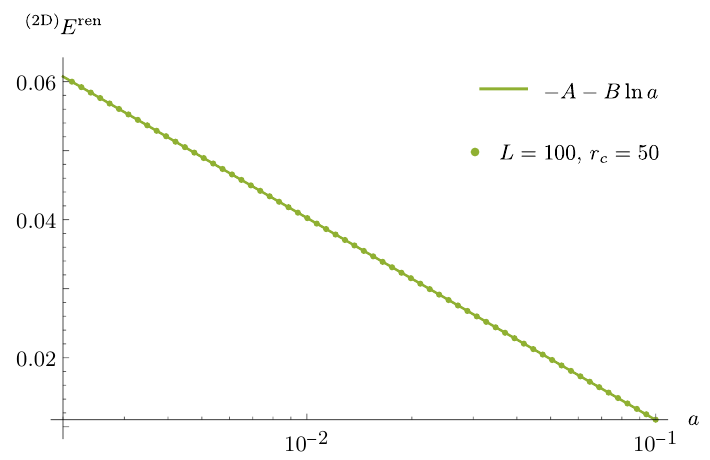
Figure 6 . Log-linear plot of the numerical Casimir energy (green data points) for R = 1 , L = 100 and r c = 50 . The function − A − B ln a , with free coefficients A and B is fitted to the data set. The resulting function, with such determined coefficients ( A, B > 0 ), is plotted as green curve. We see that the Casimir energy depends logarithmically on a .